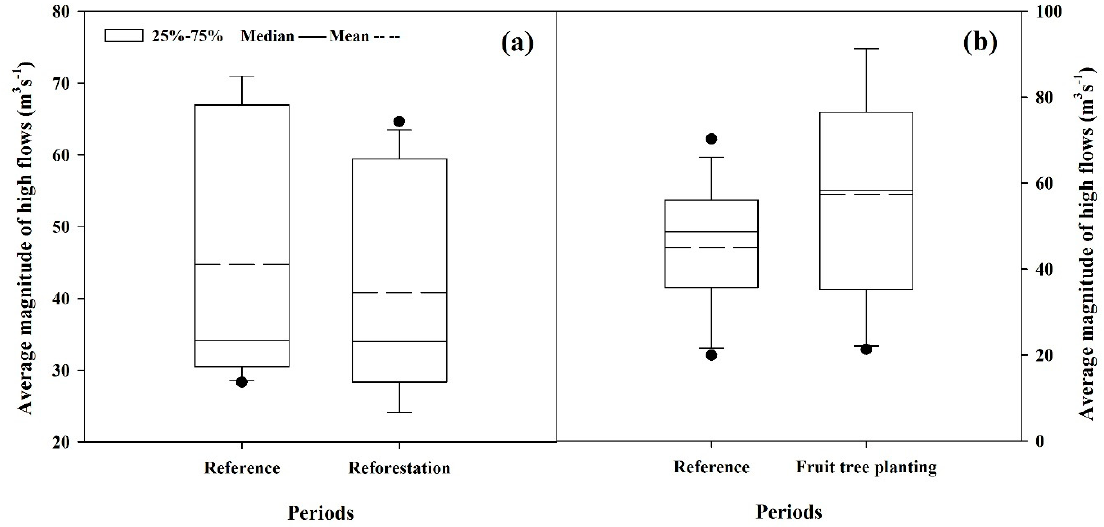
Figure 4. Comparison of the magnitudes of high flows ( a ) between the reference and reforestation periods, and ( b ) between the reference and the fruit tree planting periods.